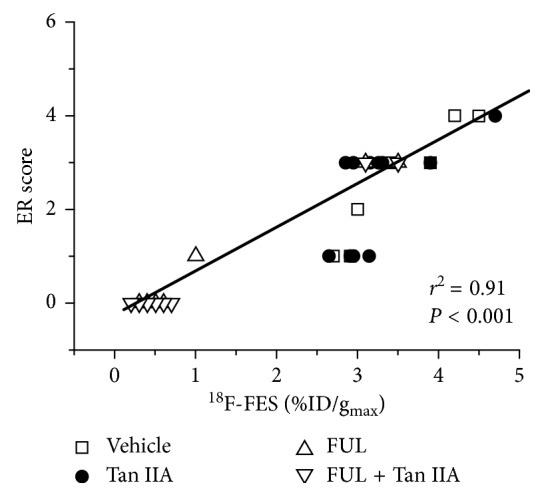
Correlation between %ID/gmax of 18F-FES uptake and ERα IHC scores. There is a significant positive correlation between 18F-FES uptake and ER expression (r
2=0.91, P < 0.001).